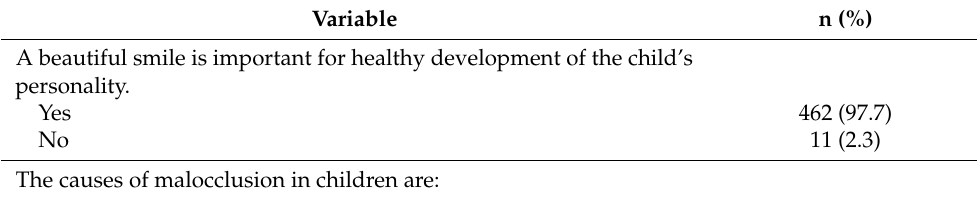
Table 2. Parents’ awareness of malocclusion and orthodontic consultation for their children. Variable n